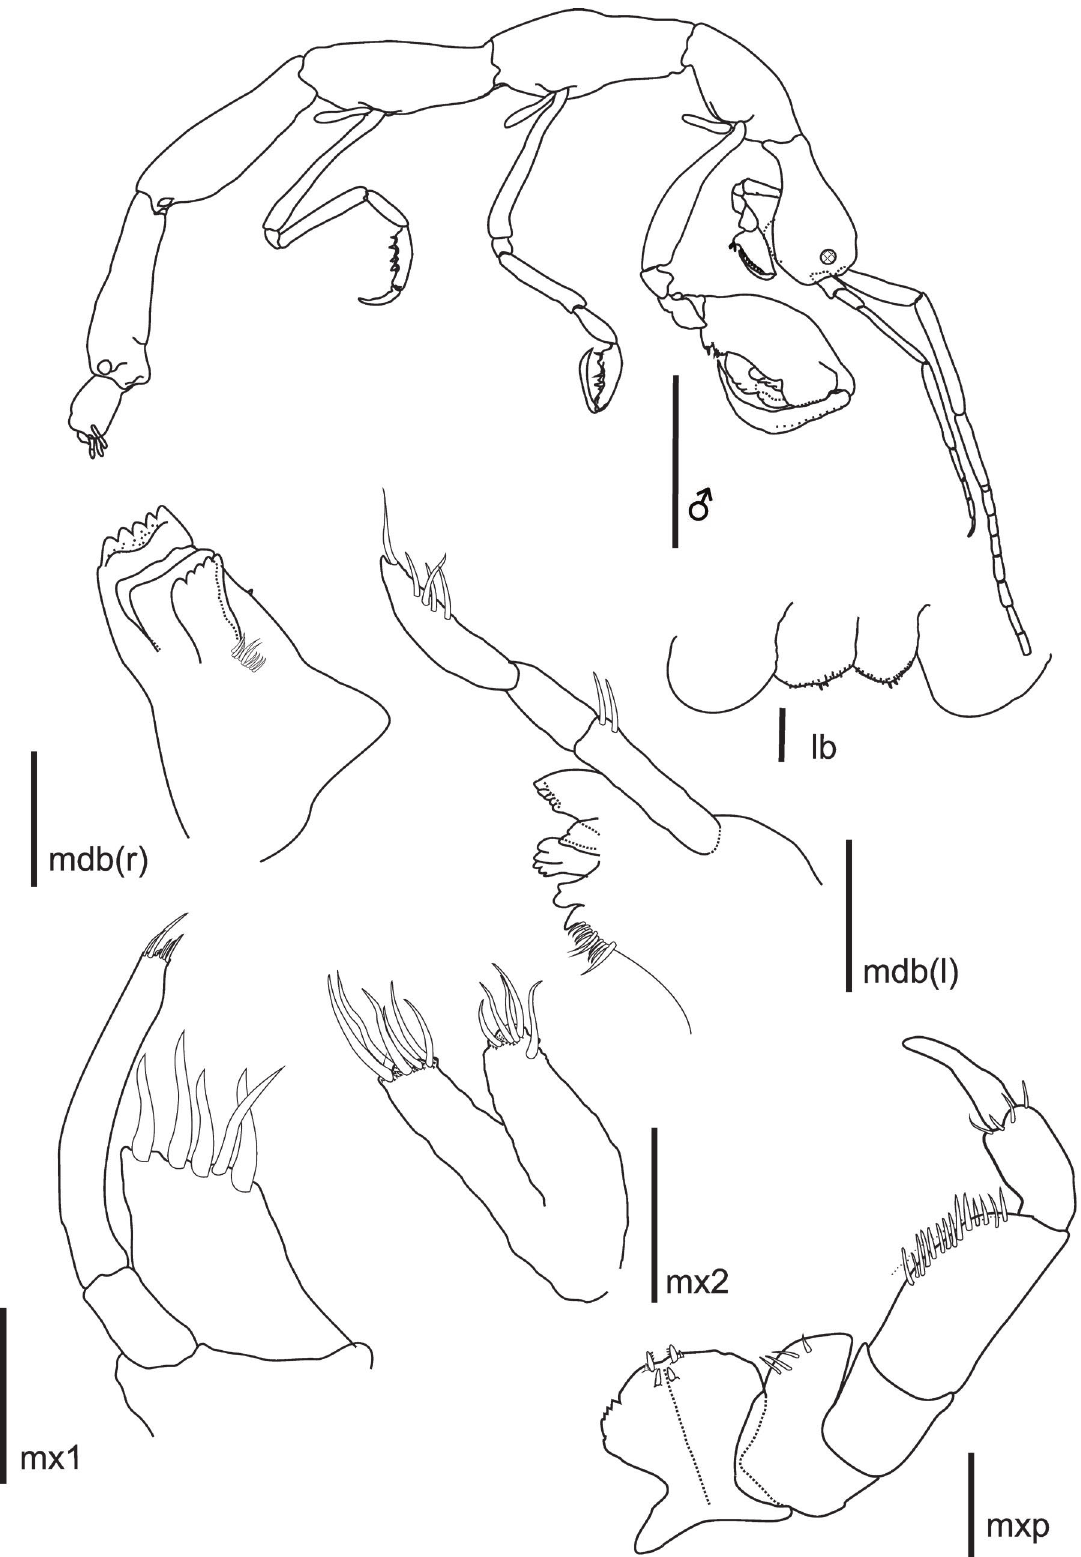
Fig. 3. Phtisica marina Slabber, 1769. Male morphotype II, 12.2 mm, Angra dos Reis, RJ (CDZRJ 1014). Scale bars: habitus = 0.5 mm; lb, mx1, mx2, mdb(l), mdb(r), mxp = 0.1